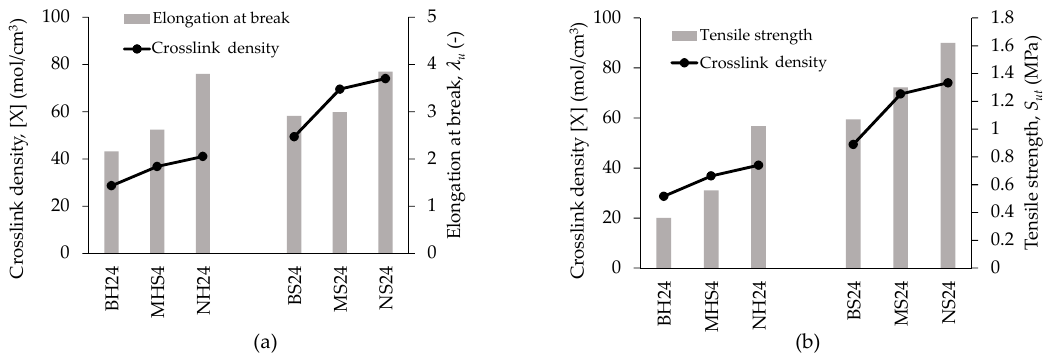
Figure 16. Influence of filler size and matrix hardness on: ( a ) elongation at break, and ( b ) tensile strength.